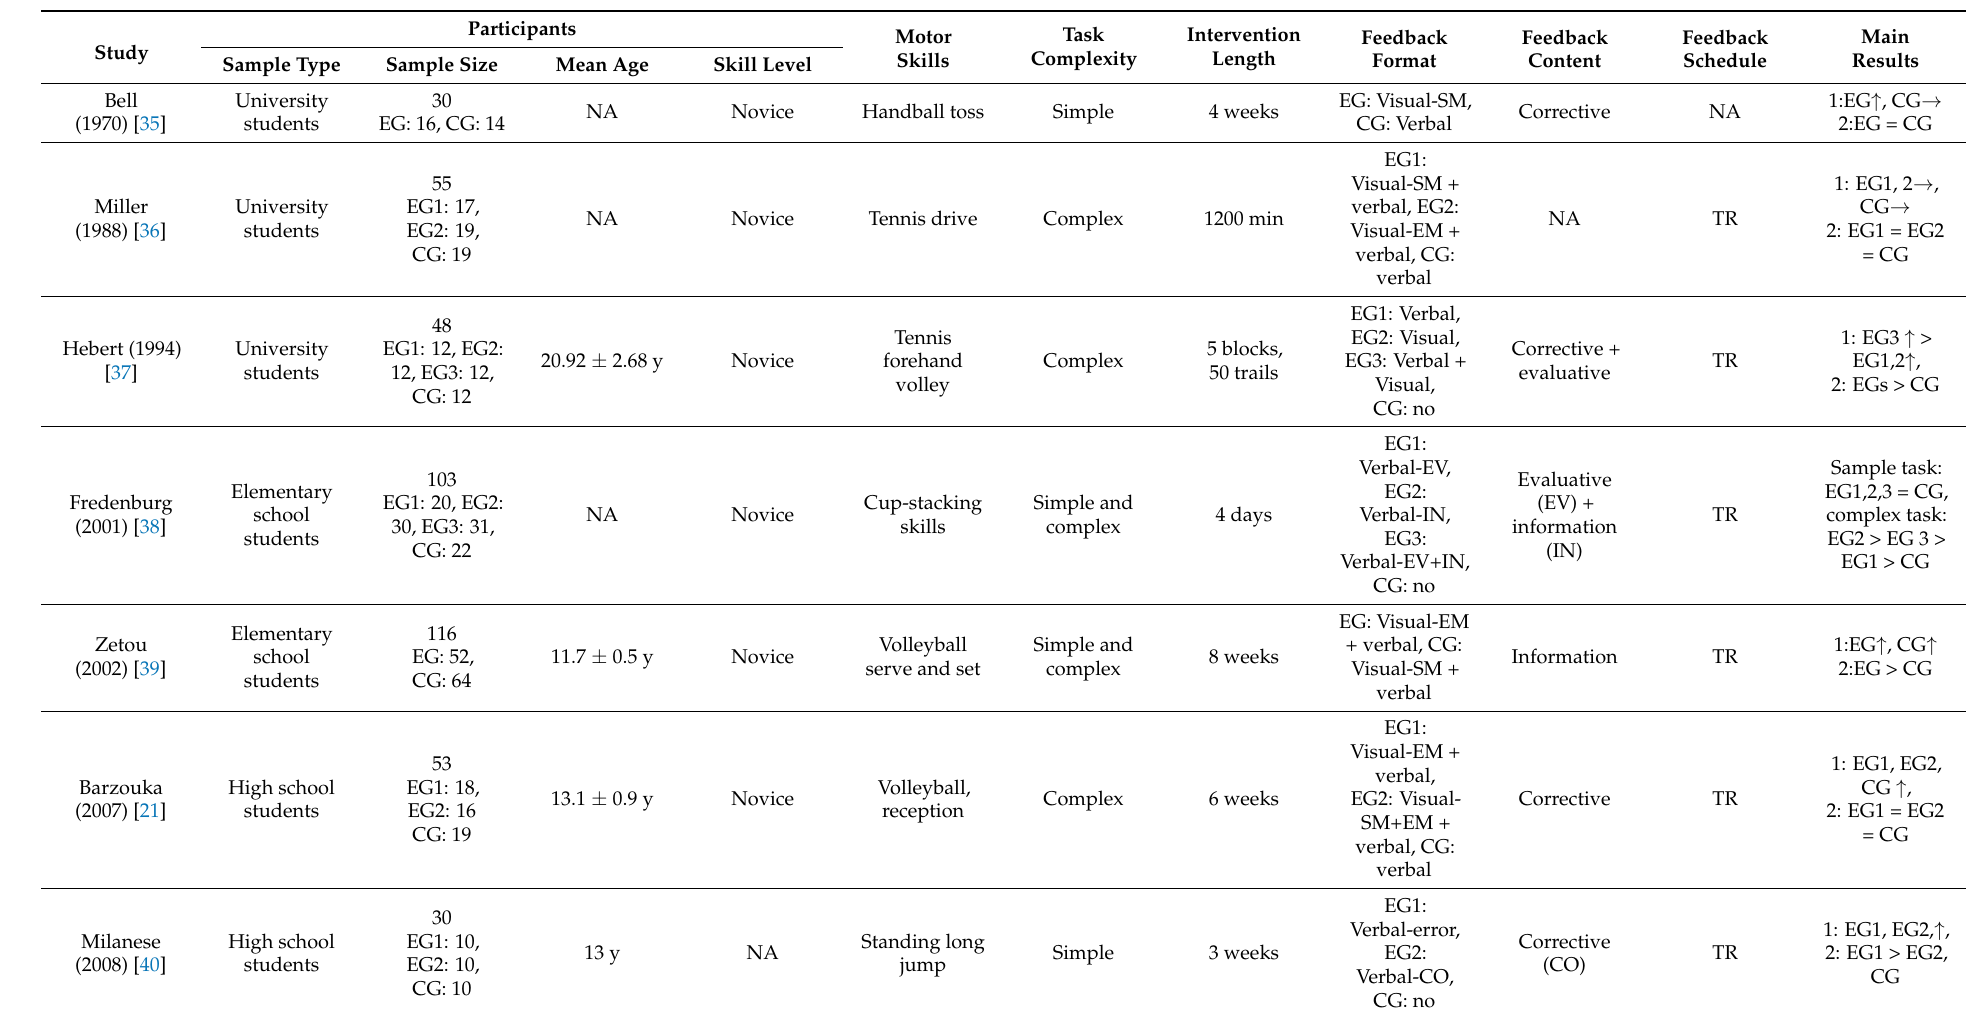
Table 2. Summary characteristics of included